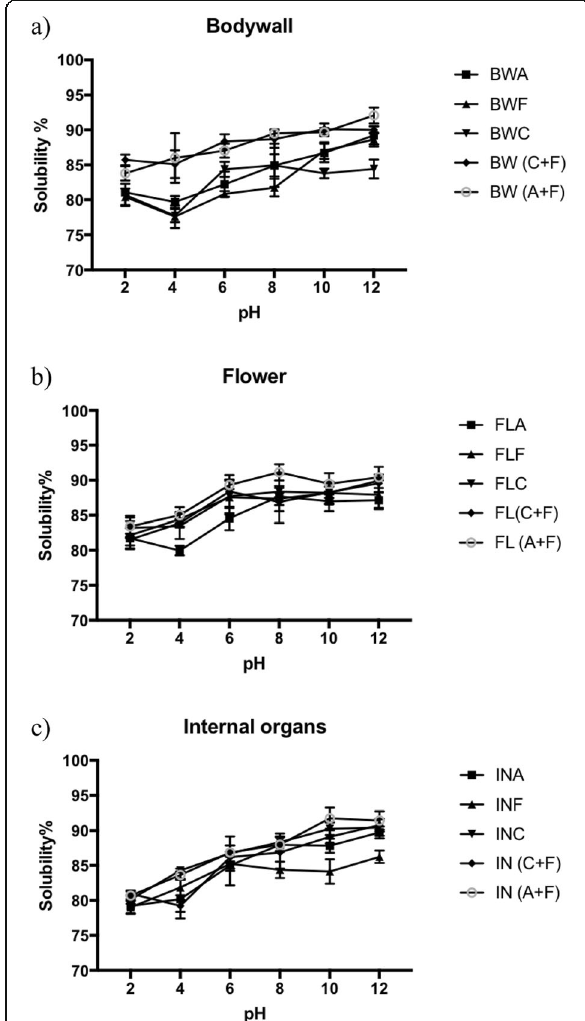
Fig. 10 Solubility of sea cucumber C. frondosa protein hydrolysates at various pH values a BW, Body wall; b FL, Flower; c IN, Internal organs A, Alcalase; F, Flavourzyme; C, Corolase; C + F, Mixture of Corolase and Flavourzyme; A + F, Mixture of Alcalase and